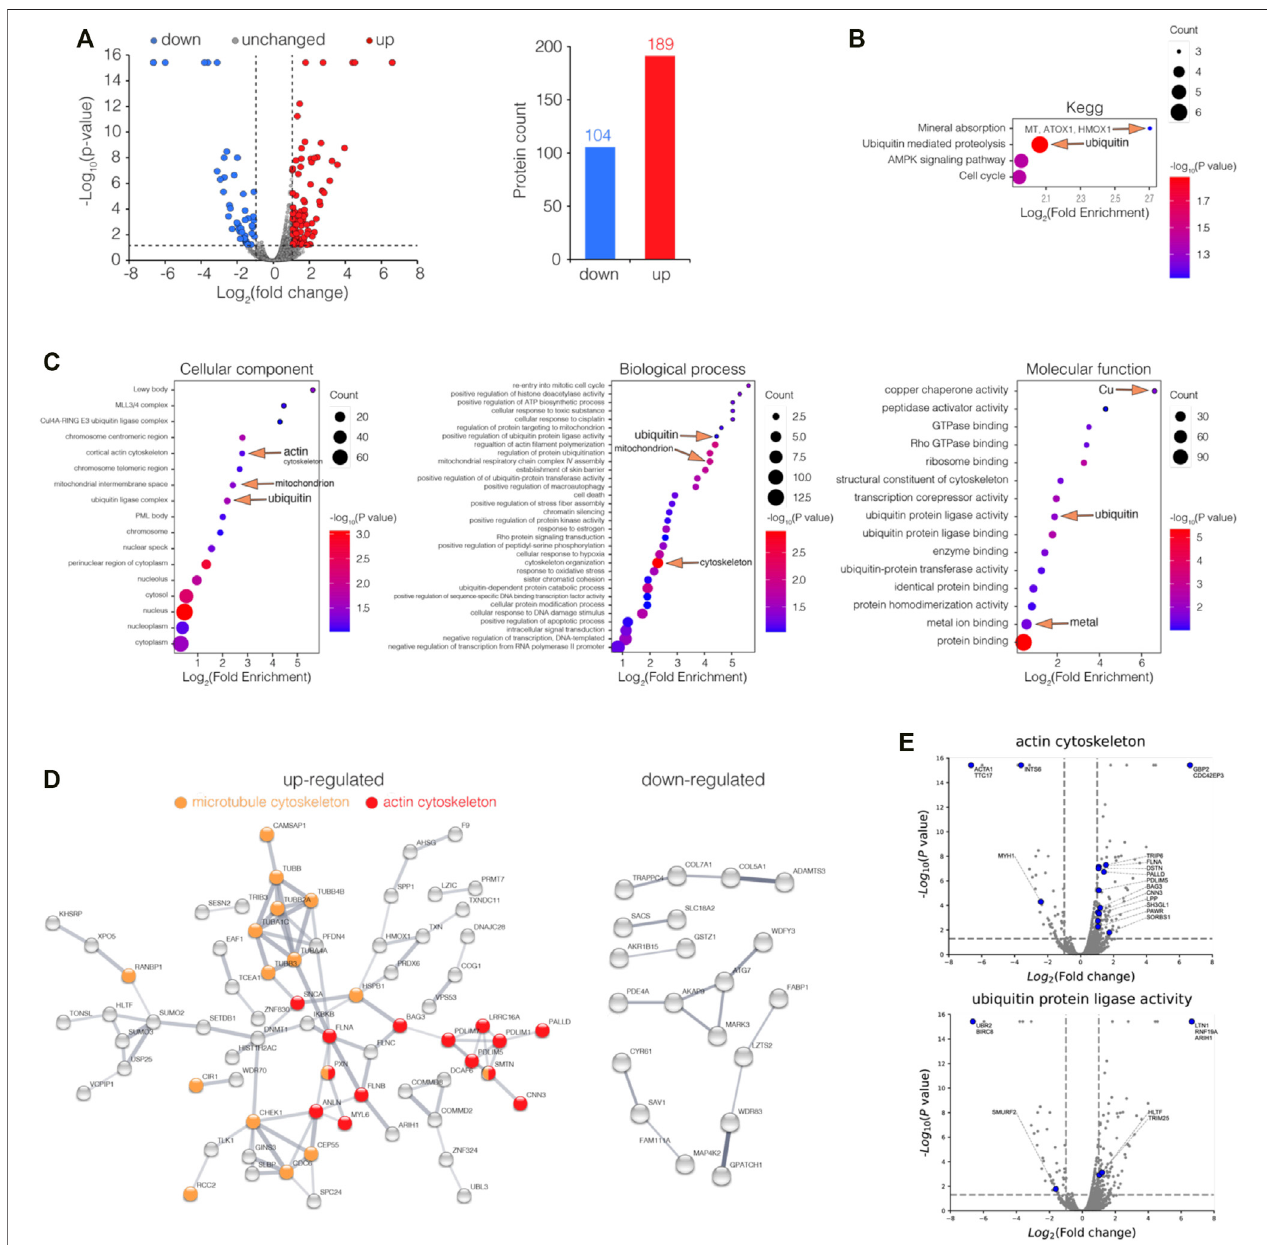
FIGURE 2 | Enrichment analysis of differentially expressed proteins (DEPs) in GSH-depleted HK-2 cells upon bismuth treatment. (A) Volcano plot visualizations of DEPs (fold of change > 2 or < 0.5, p value < 0.05) in GSH-depleted HK-2 cells treated with 500 μ M CBS for 24 h, and 189 and 104 proteins were up and downregulated among 6,230 proteins, respectively. (B) Enrichment analysis of DEPs in GSH-depleted HK-2 cells treated with CBS, in perspective of KEGG, and (C) GO cellular component, molecular function, and biological process. (D) Protein – protein interaction networks of both up and downregulated DEPs generated using STRING. (E) Volcano plots visualizing DEPs involved in GO terms: actin cytoskeleton and ubiquitin protein ligase activity. The cells were treated with 500 μ M L-BSO for 24 h to remove GSH before CBS treatment. CBS induces MT expression only in the absence of GSH.